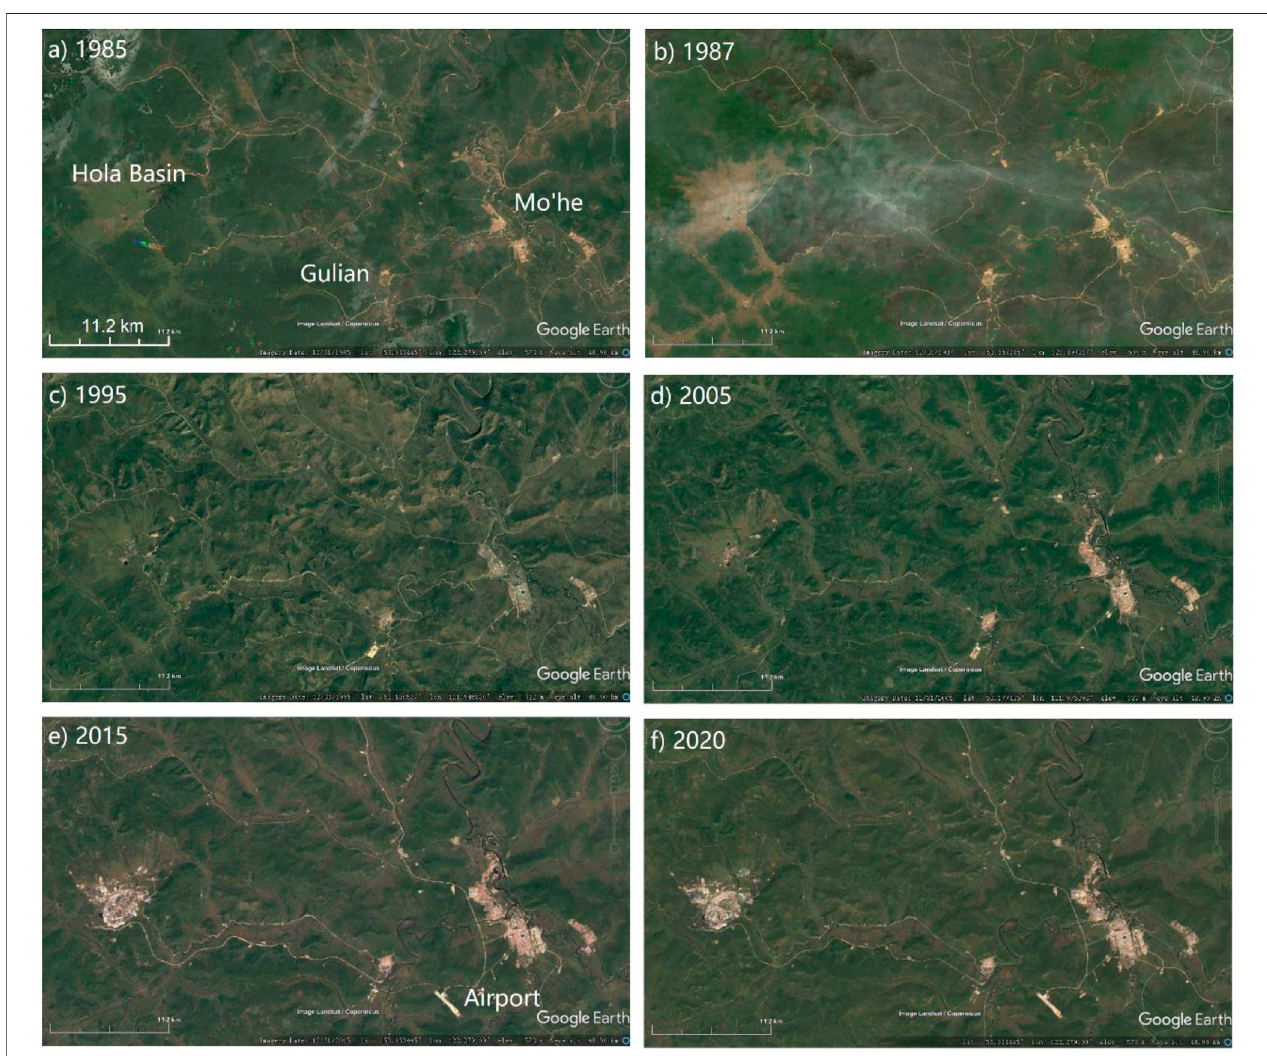
FIGURE 5 | Landscape changes in Mo ’ he, Gulian and Hola basins in Mo ’ he County in northern Heilongjiang Province, Northeast China from 1985 to 2020. Panel (A – F) is the expansion of Mo ’ he and Gulian towns, panel (A – D) is the expansion of coal mines at Hola and basins and roads, panel (E,F) represents the construction of airport, and panel (B) represents the forest fi re in